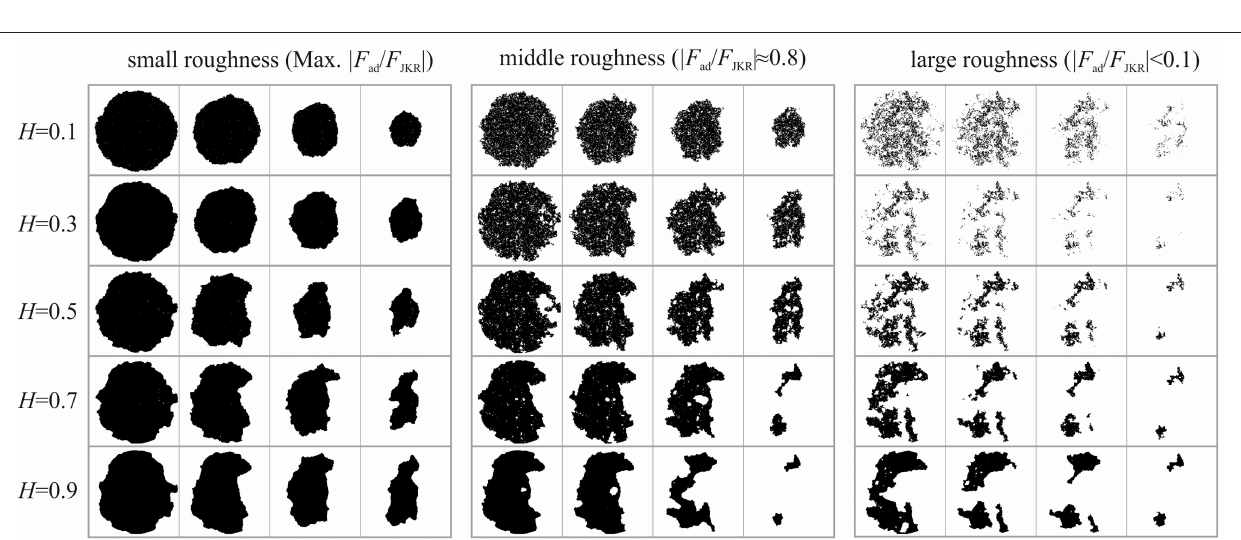
FIGURE 8 | Series of contact configurations during the pull-off